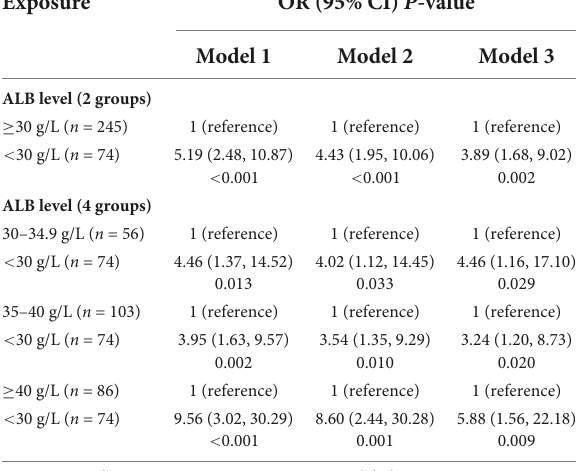
Model 1 adjusted for: age (months, ≤ 36 months, > 36 months), and gender(male,female). Model 2 adjusted for: model 1+ Kawasaki disease type (complete, incomplete), IVIG therapeutic effect (sensitive, resistance), treatment regimen (standard, non-standard), andtimeofIVIGtreatment(delayed,non-delayed). Model 3 adjusted for: model 2+ C-reactive protein level ( ≤ 70 mg/L, > 70 mg/L), white blood cell count ( ≤ 18 × 109/L, > 18 × 109/L), platelet count ( ≤ 450 × 109/L, > 450 × 109/L),andalanineaminotransferaselevel( ≤ 45U/L, > 45U/L).